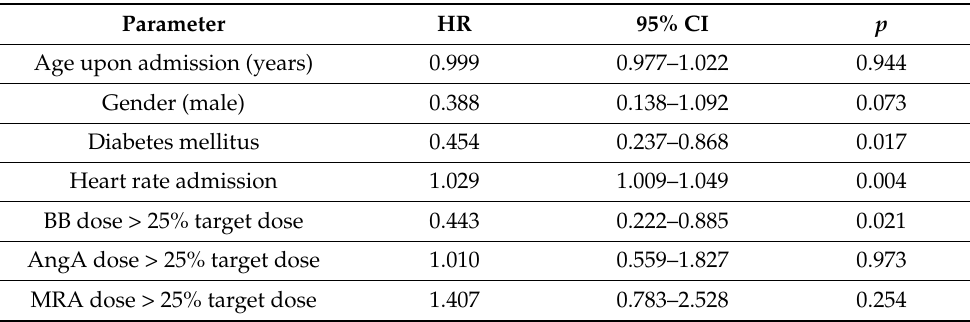
Table 3. Cox proportional - hazards multivariate model for ventricular arrhythmia .